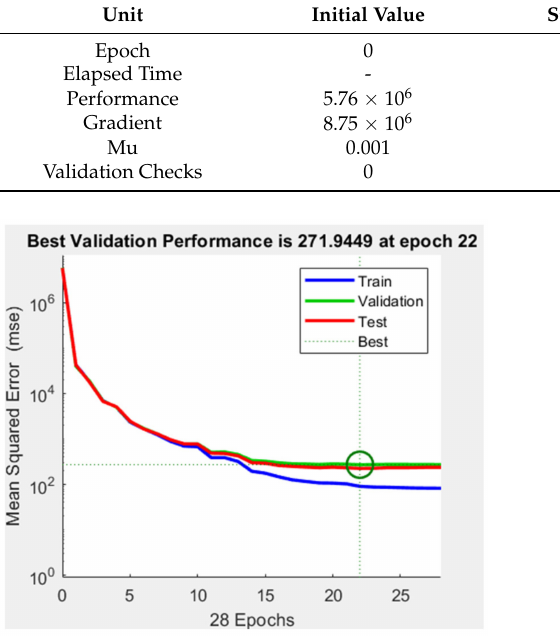
Figure 12. ANN teaching performance for a model with five neurons in the